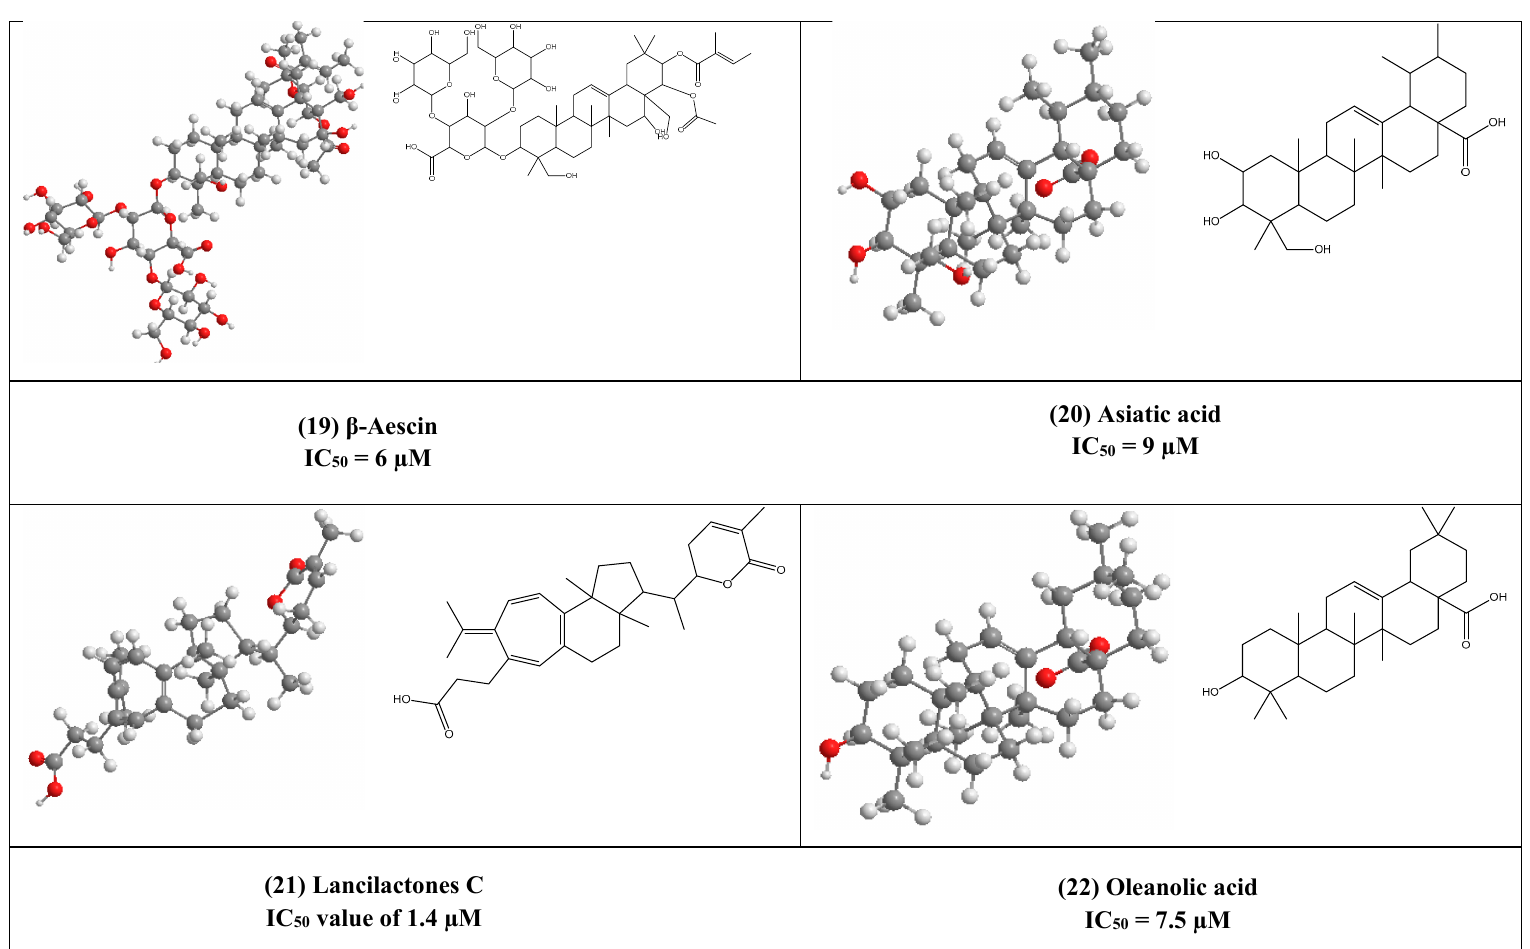
Figure 5. The 2D and 3D chemical structures of virus replication inhibi-